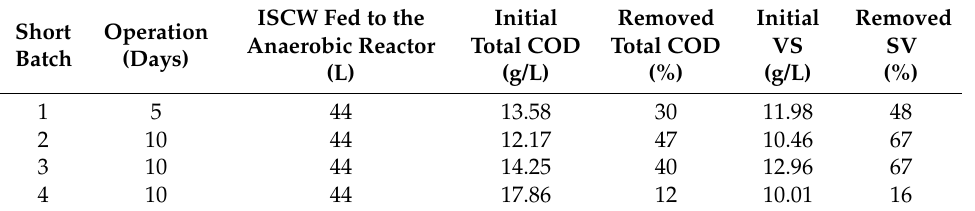
Table 4. Evaluation of digestion over short periods of time.